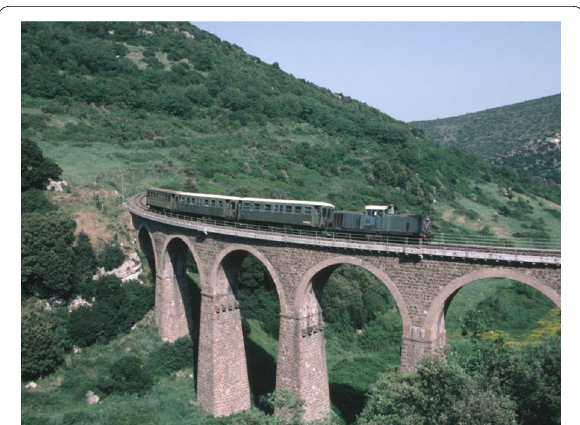
Fig. 5 The Trenino Verde (Source: Photo from http://www.treni nover